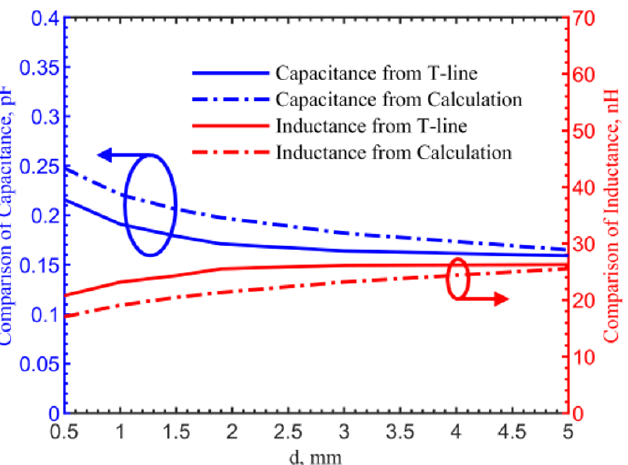
Figure 13. Comparison of the theorical and transmission-line model values for the capacitance and inductance of the tuned